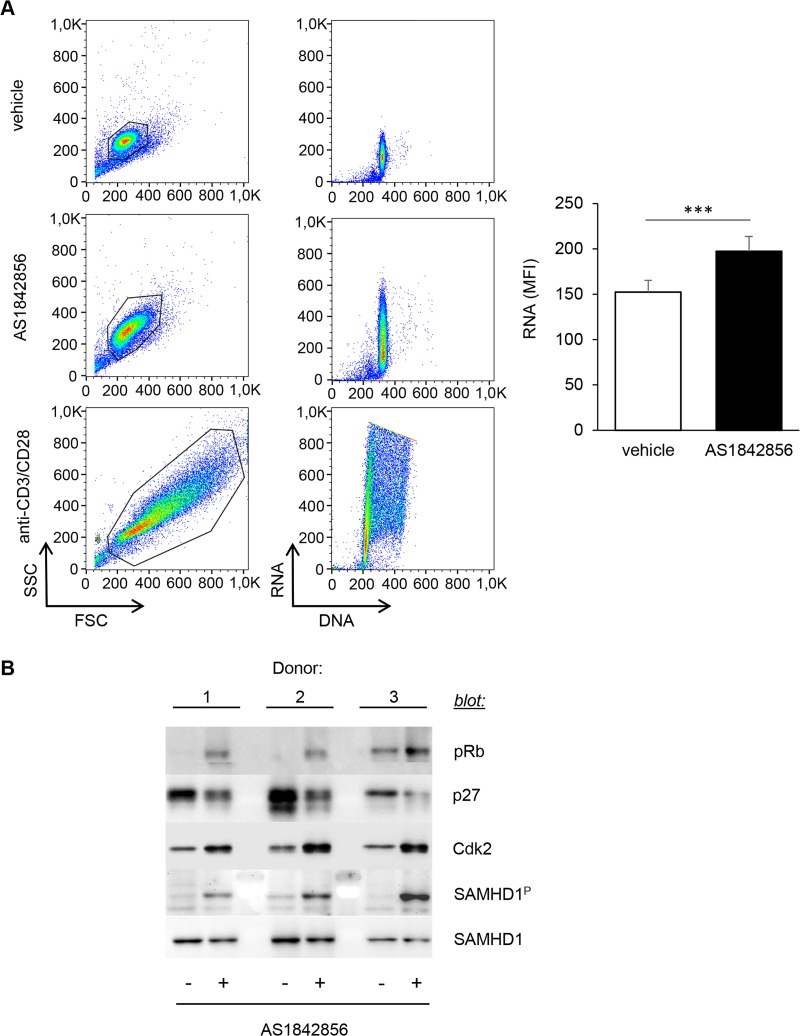
AS1842856 leads to a transition from quiescence to the G1 phase of the cell cycle of T lymphocytes.(A) PBT were cultured for 7 days in the presence of AS1842856 (500nM) or vehicle only. RNA and DNA cell content was measured by FACS on the gated cells after acridine orange staining. Untreated T cells activated for 3 days with anti-CD3/CD28 beads were used as a positive control of cells increasing both their RNA and DNA content. Result obtained with one representative donor (left panel) and mean results +/- SE with cells from 7 independent donors (right panel) are shown. (B) PBT from 3 independent donors were cultured as in A, then collected, lysed and immunoblotted using specific antibodies against p27, Cdk2 and SamHD1 proteins. The same lysates were also analyzed for Rb and SAMHD1 phosphorylation with phospho-specific antibodies.